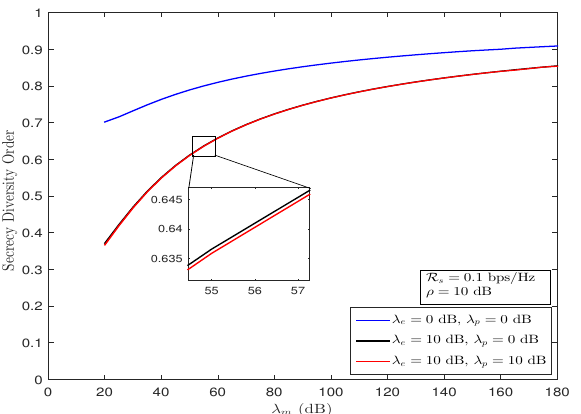
Figure 3. Secrecy diversity order behavior of the considered system under Strategy I for λ m → ∞ and fixed λ e